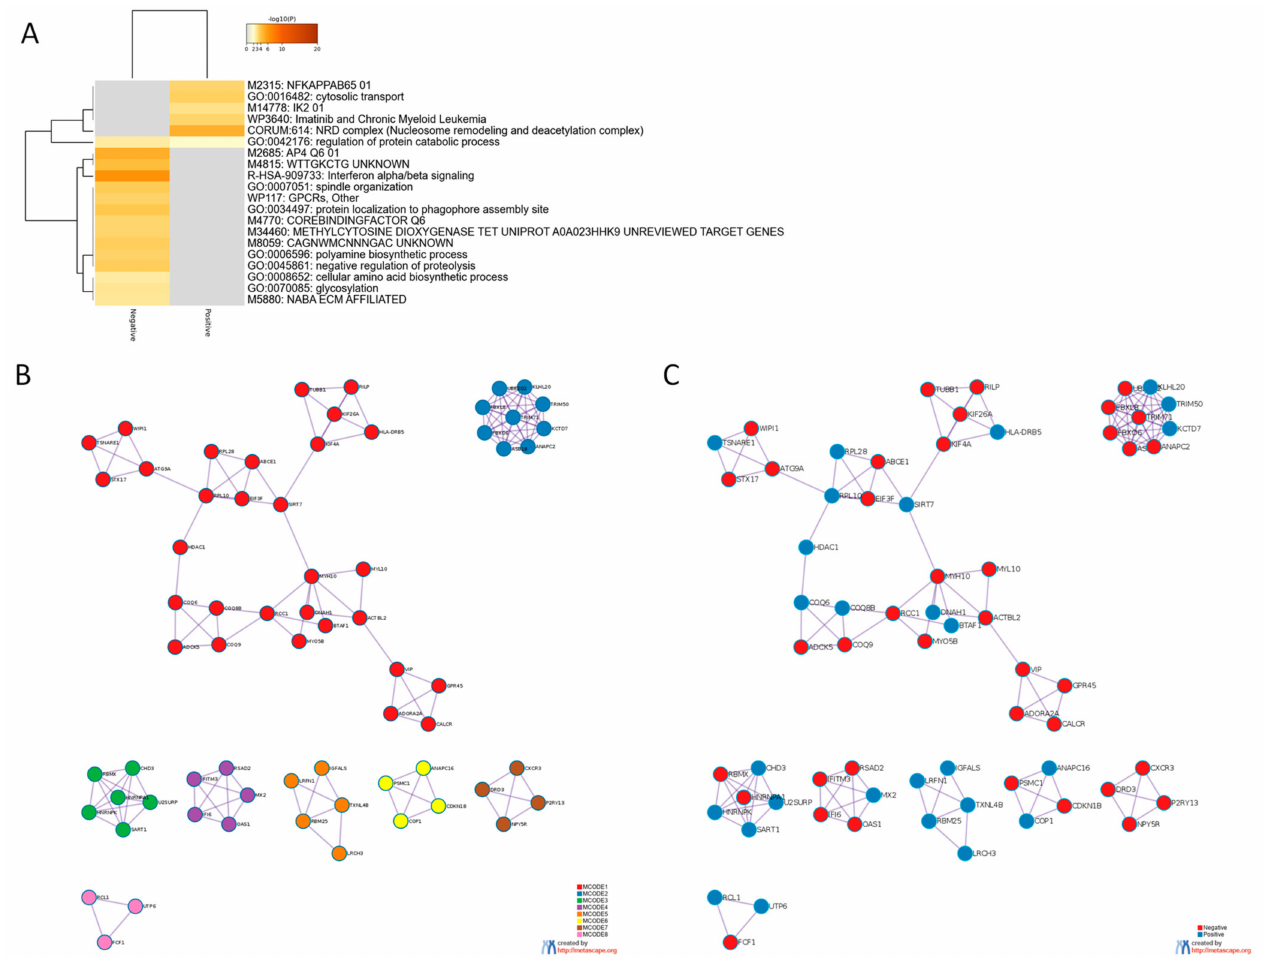
Figure 3. Gene Ontology and MCODE analysis for the genes that correlated most with TSPAN32 in SLE plasmablasts. Genes significantly correlated to TSPAN32 in SLE plasmablasts were identified by calculating the cosine similarity and the statistical significance was computed using a permutation test, with 1000 random permutations. ( A ) Hierarchical clustering showing the most enriched biological processes and gene ontologies among the genes significantly correlated to TSPAN32, as determined using the web-based utility, Metascape. ( B ) MCODE (Molecular Complex Detection) clusters enriched among the genes significantly correlated to TSPAN32. ( C ) MCODE clusters showing the genes based on their correlation to